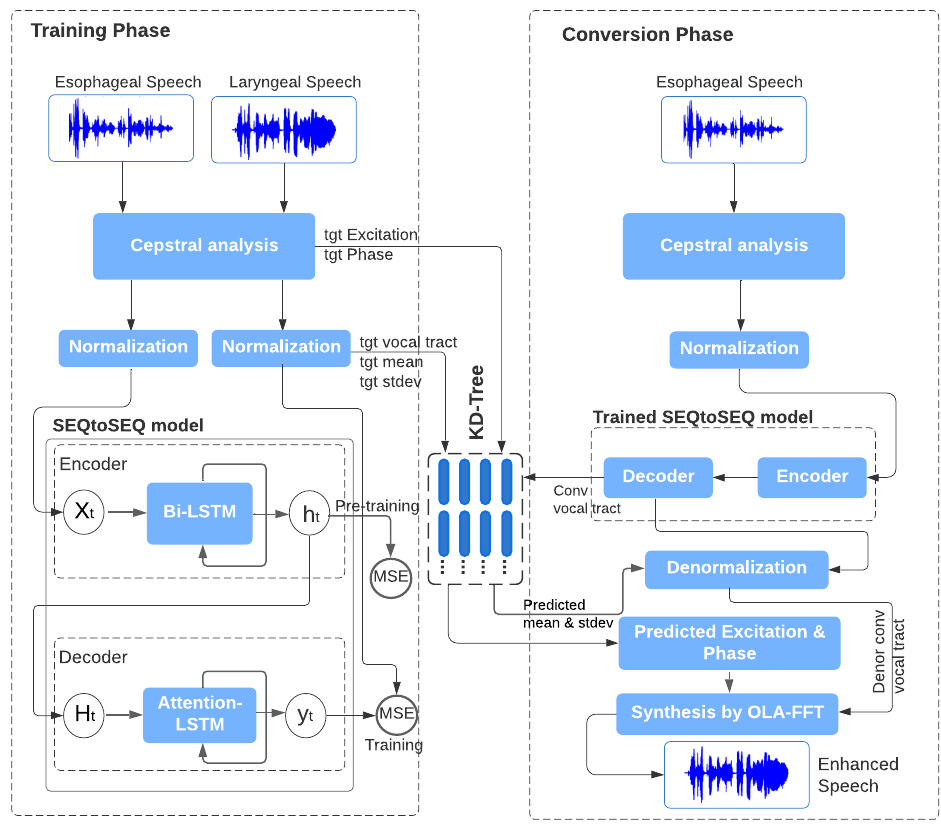
Figure 1. An overview of the proposed esophageal speech enhancement framework based on a Seq2Seq